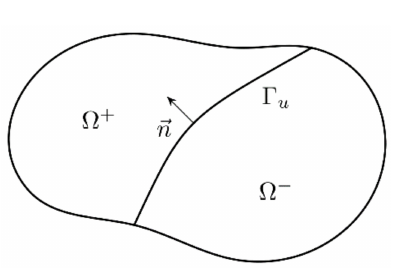
Figure 2. Body cut by a